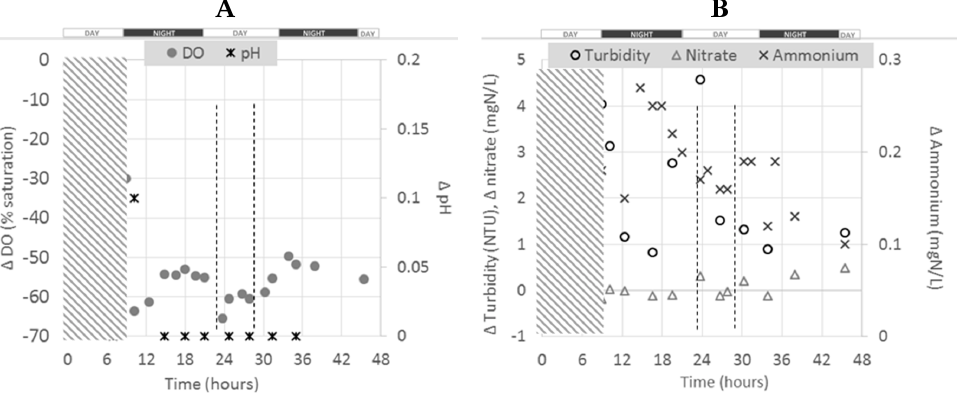
Figure 5. Pond 1 5 differential values between outlet and inlet for dissolved oxygen and pH ( A ) and for turbidity, nitrate and ammonium ( B ) during the monitoring program. The inlet monitoring location was changed after 8 h of monitoring. Vertical dash lines represent feeding times.